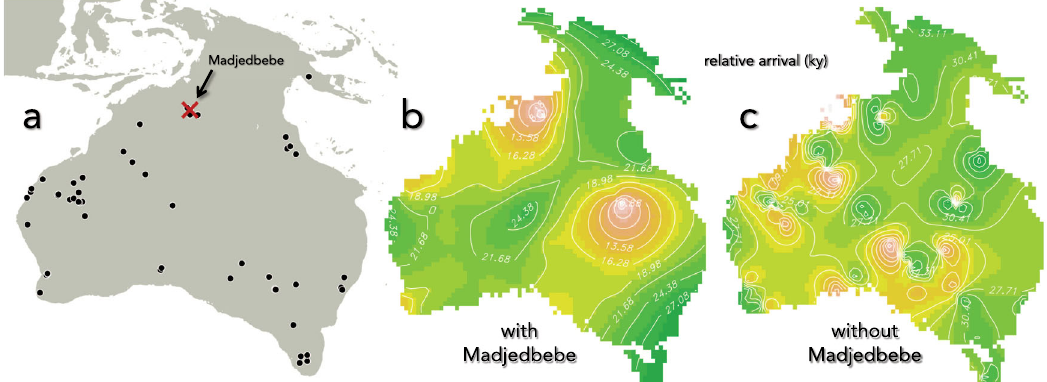
Fig. 1 Spatial reconstructions of oldest archaeological dates. a Distribution of reliable (A* and A quality-rated) archaeological dates older than 30,000 years used to generate b a Signor – Lipps- and spatial-bias-corrected map layer of fi rst arrival (see details in ‘ Methods ’ ); in c we removed the disputed 1,5,45 – 48,95 Madjedbebe dates (position indicated in a by a red cross) and reconstructed the layer. All date isohyets in b and c are expressed in 1000-year (ky) increments relative to arrival time and are based on 100 simulated replicates of the spatial-inference algorithm. Colours indicate progressively earlier (pink) to later (green) archaeologically derived dates. See ‘ Methods ’ (Cellular-automaton framework) for the source of the map extent for Sahul.